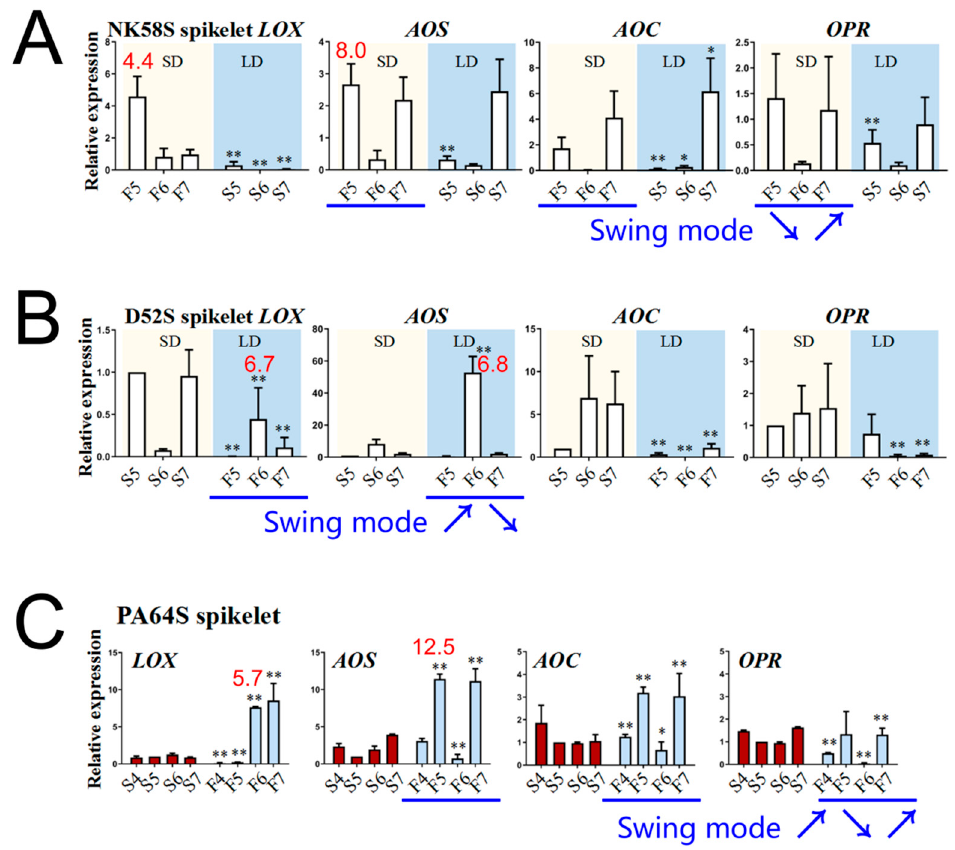
Figure 4. Expression analysis of JA synthesis enzyme genes in fertility-induced plants under different photoperiod and temperature conditions. The qPCR analysis of LOX , AOS , AOC and OPR genes in spikelets of NK58S ( A ), D52S ( B ) and PA64S ( C ) sterile/fertile lines from the 4th to 7th stages. The internal reference gene is OsActin . PA64S treated by HT/LT are columnar with the red and blue color, respectively. NK58S and D52S treated by LD/SD photoperiod are marked with a blue and yellow background, respectively. Data are shown as mean ± standard deviation ( n = 3). Asterisks indicate significant differences between sterile and fertile plants of the same period revealed by Student’s t -test (*, p < 0.05; **, p < 0.01). The significant FC of gene expression in fertile plants compared to those in sterile plants are listed above the columnars in red. The blue arrows represent the trend and direction of gene expression change in fertile plants. LD, long-day cycle; SD, short-day cycle; HT, high temperature; LT, low temperature; S/F, sterile/fertile plants; 4/5/6/7, 4th/5th/6th/7th-stage.